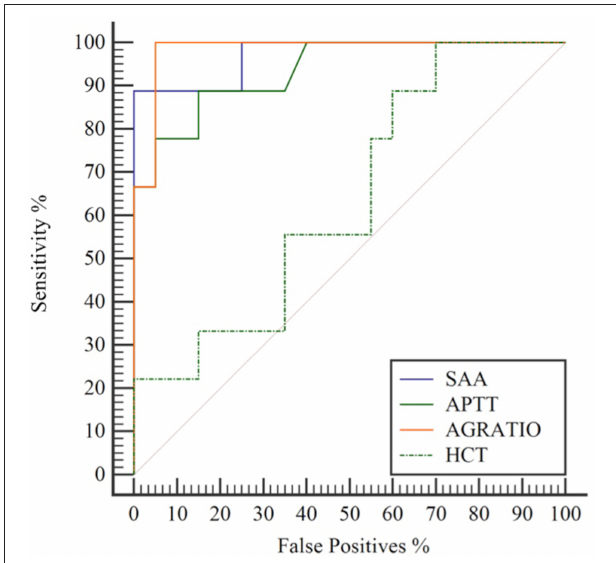
FIGURE 1 | Comparison of receiver operating characteristic (ROC) curves depicting highly accurate serum amyloid A (SAA; blue solid line), activated prothrombin time (APTT; green solid line), and albumin:globulin ratio (A:G ratio; orange solid line) in contrast to less accurate hematocrit (HCT; green dashed line) for diagnosis of Otostrongylus circumlitis clinical infections in Northern elephant seals ( Mirounga angustirostris